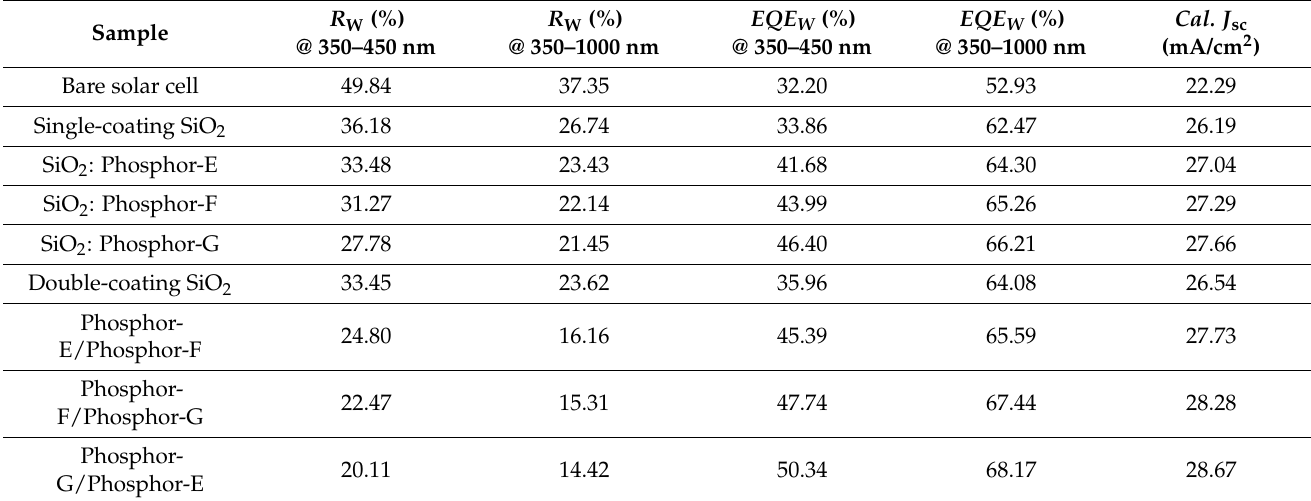
Table 1. Average weighted reflectance ( R W ) and average weighted external quantum efficiency ( EQE W ) calculated for wavelength ranges of 350–450 nm and 350–1000 nm. Integrated J sc values calculated from EQE spectra (350–1000